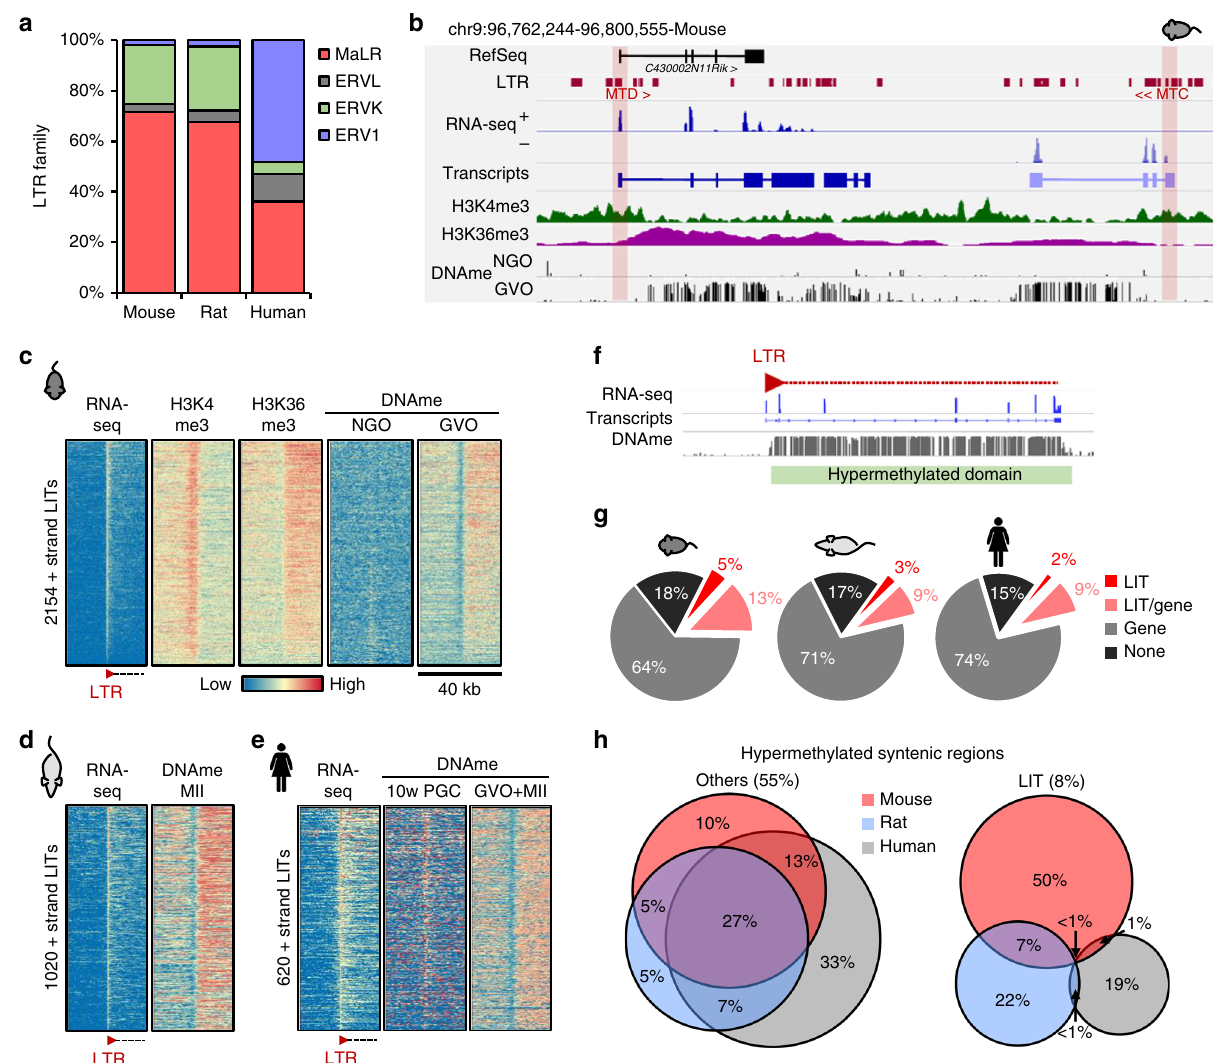
Fig. 2 LTR-initiated transcription impacts species-speci fi c DNAme in oocytes. a Bar chart of the relative contribution of LTR retrotransposon classes driving all LITs in mouse, rat, and human oocytes. b Screenshot of genic and intergenic LITs resulting in two hypermethylated domains in mouse oocytes: the canonical TSS of the C430002N11Rik gene is embedded in an MTD, and a second intergenic transcript initiates in an MTC. Both LTR promoters are enriched for H3K4me3 while the downstream de novo methylated regions are enriched for H3K36me3 in GVO. c – e Heat maps of the correlation between transcription and downstream ( + strand) DNAme at 2154 LITs (TSS ±20 kb) in mouse oocytes, 1020 LITs in rat oocytes, and 620 forward strand LITs in human oocytes. NGO non-growing oocytes, GVO germinal vesicle oocytes, MII metaphase II oocytes, 10 wk PGCs 10-week female PGCs (human). f Cartoon illustrating a DNA methylated genomic region that is overlapped by an LIT. g Pie charts showing the proportion of hypermethylated regions (normalized to the domain size) that are overlapped by an LIT and/or an annotated Ensembl gene in mouse, rat, or human oocytes. h Venn diagrams showing syntenic 1 kb bins that are hypermethylated (>70% DNAme) in mouse, rat, and/or human oocytes. Syntenic regions that overlap with an LIT (right) show signi fi cantly greater divergence in DNAme between species than the rest of the genome (left). The percentage of total syntenic genomic regions (433, 111 1 kb bins with >5 CpGs with >5× coverage) is indicated above each Venn diagram. Mouse and human WGBS datasets analyzed from refs. 11,12,16,23 , human RNA-seq data from ref. 17 , and mouse H3K4me3 from ref.